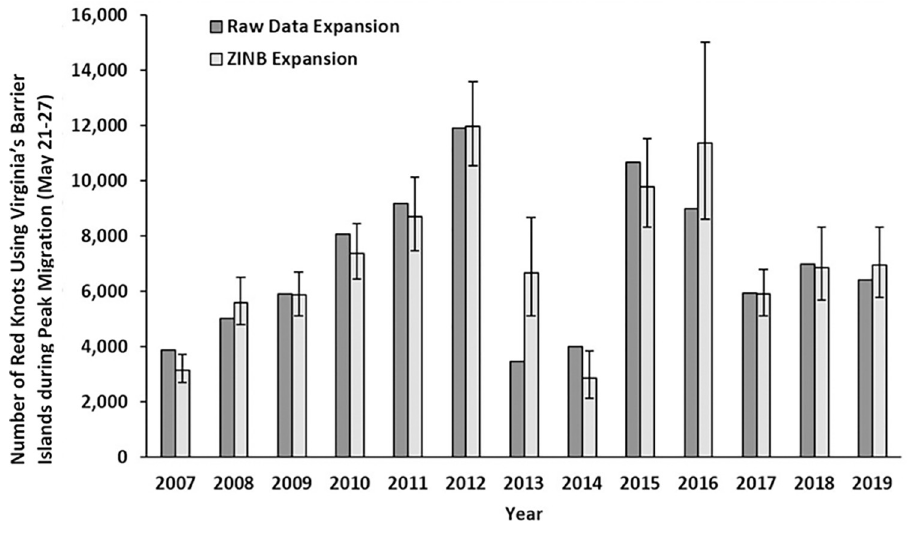
Fig 3. Peak counts of red